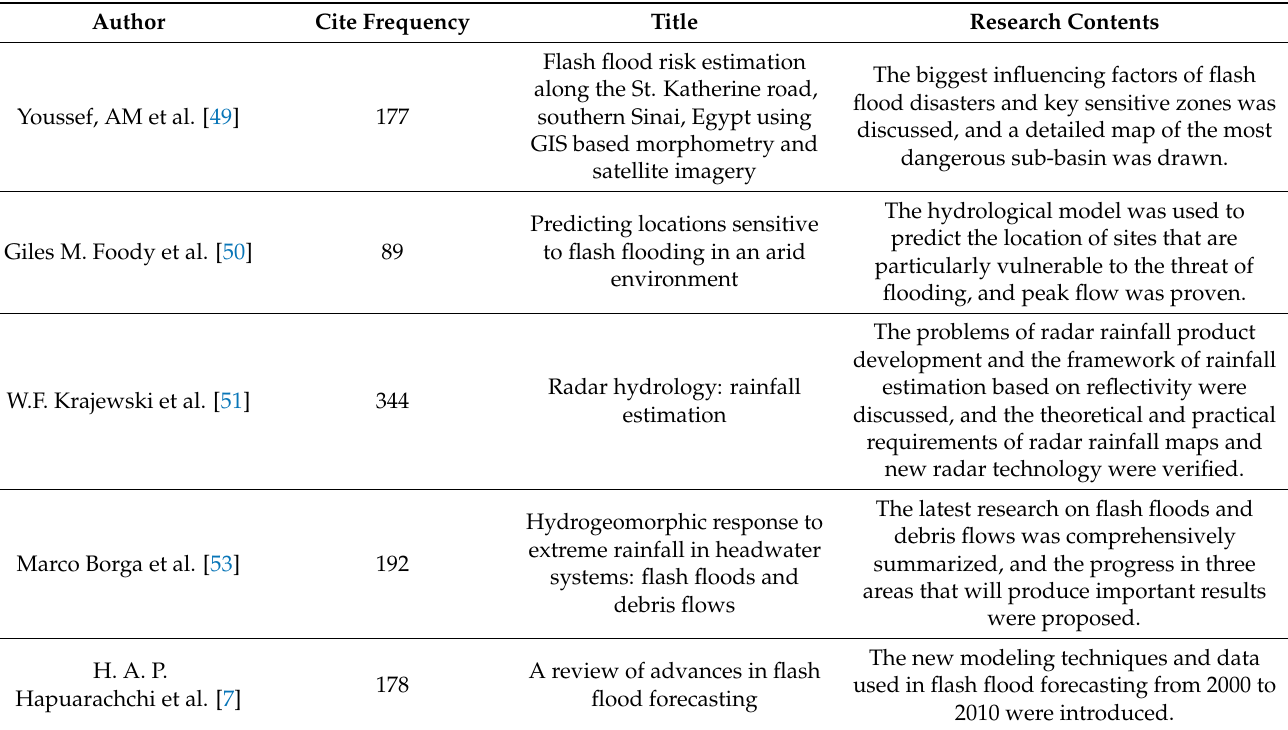
Table 1. Hot spot analysis of highly cited articles, classified from 248 articles using remote sensing to study flash